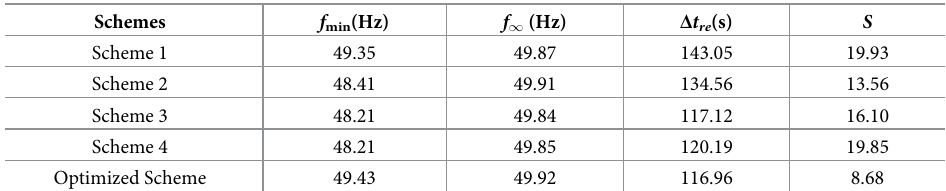
Table 5. Simulation analysis results.